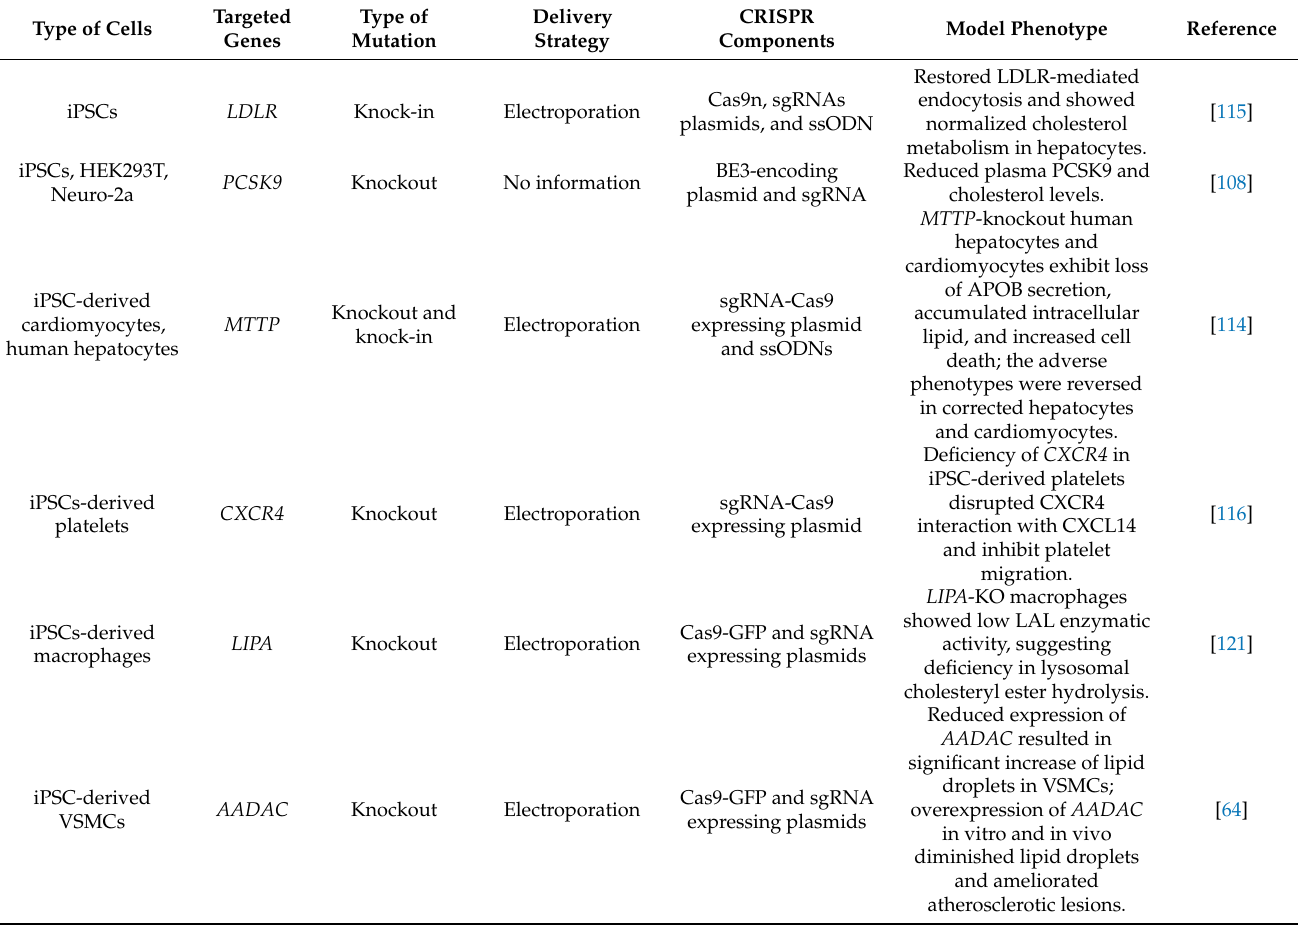
Table 1. CRISPR/Cas9 genome editing in atherosclerosis models (in